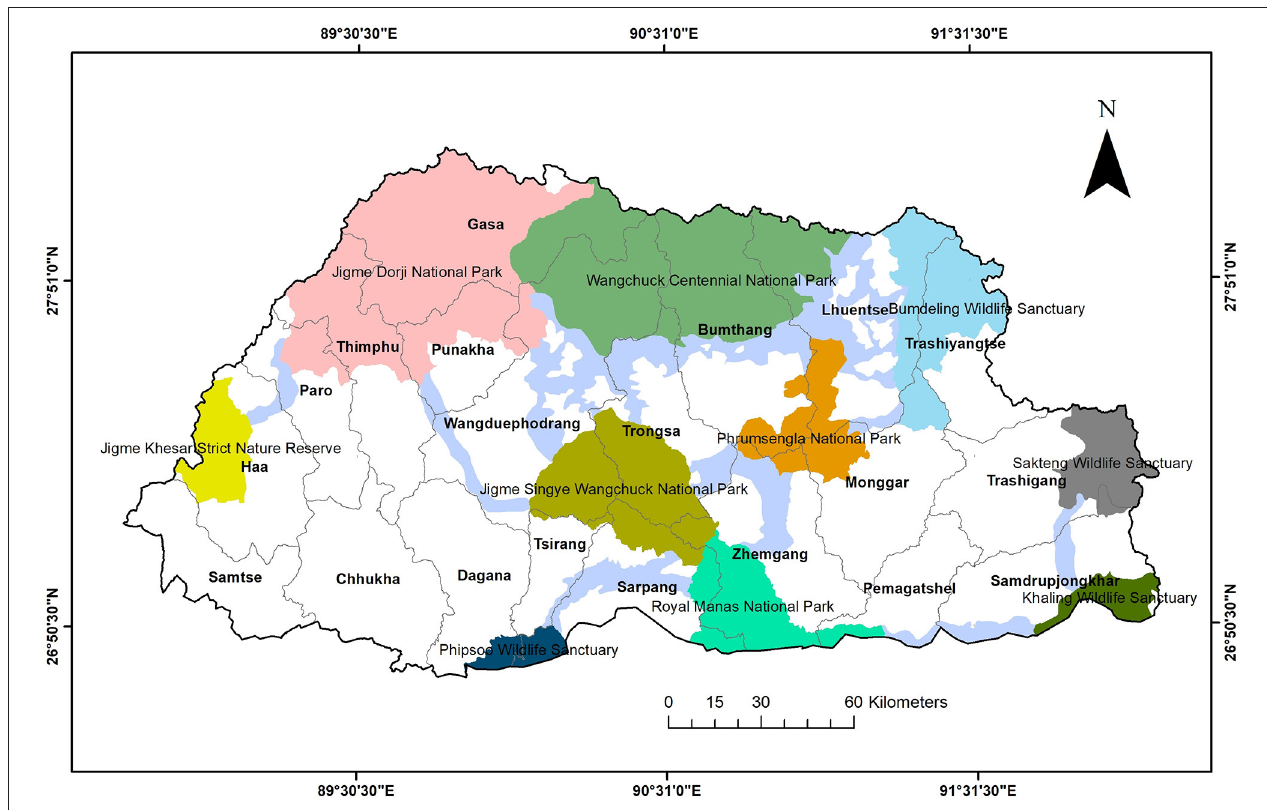
FIGURE 1 | National parks, wildlife sanctuaries, a strict nature reserve (colors), biological corridors (light blue), and dzongkhags (districts, black outlines) of Bhutan.